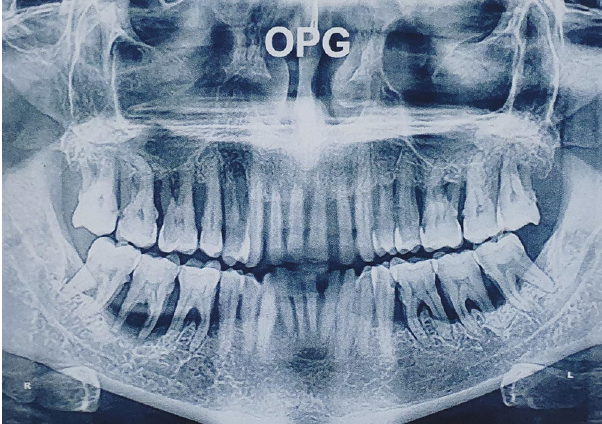
Figure 2: Orthopantomograph examination.